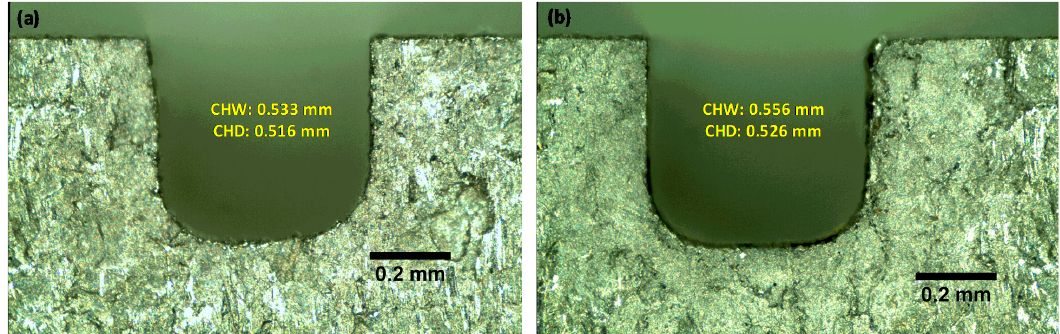
Figure 7. Microchannel width and depth at ( a ) low average voltage (35 V) and ( b ) high average voltage (75 V).